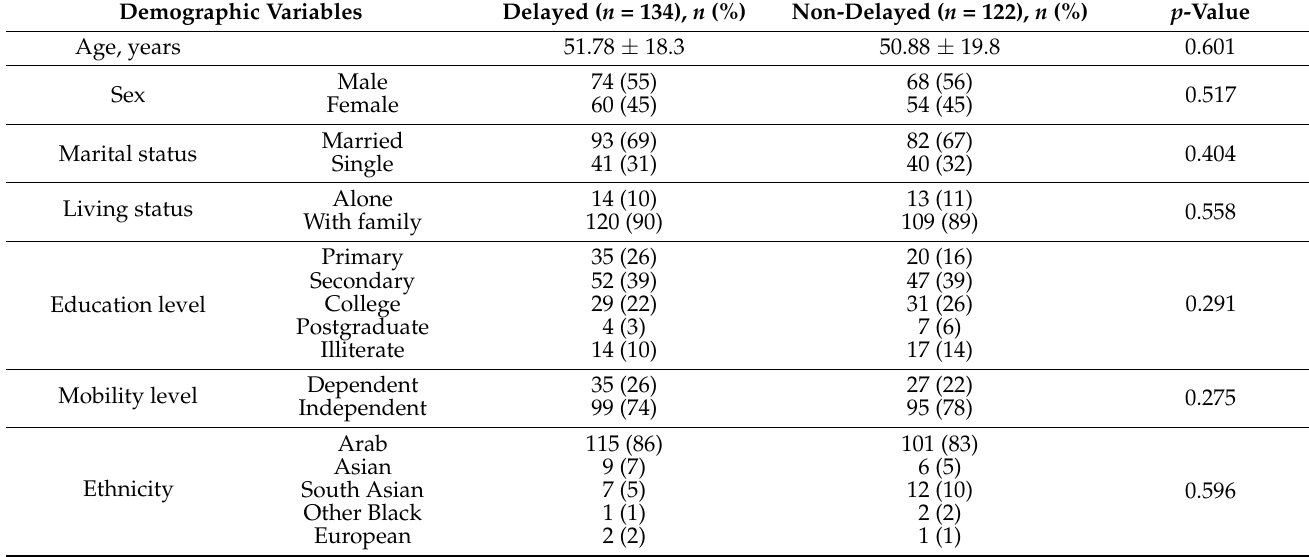
Table 1. Demographics and baseline characteristics of patients presenting to the